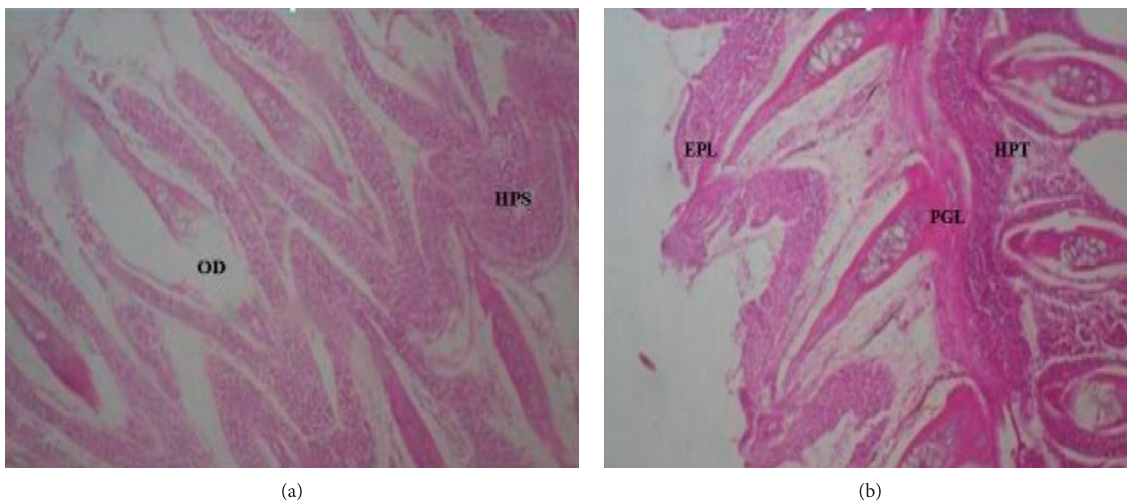
Figure 9: (a) Histological section of gill exposed to bulk Al 2 O 3 /CuO (2:1) showing oedema (OD) and epithelial hyperplasia (HPS) (H&E stains, × 400). (b) Histological section of gill exposed to bulk Al 2 O 3 /CuO (1 :2) showing primary gill lamella (PGL), epithelial lifting (EPL), and hypertrophy (HPT) (H&E stains, × 400).